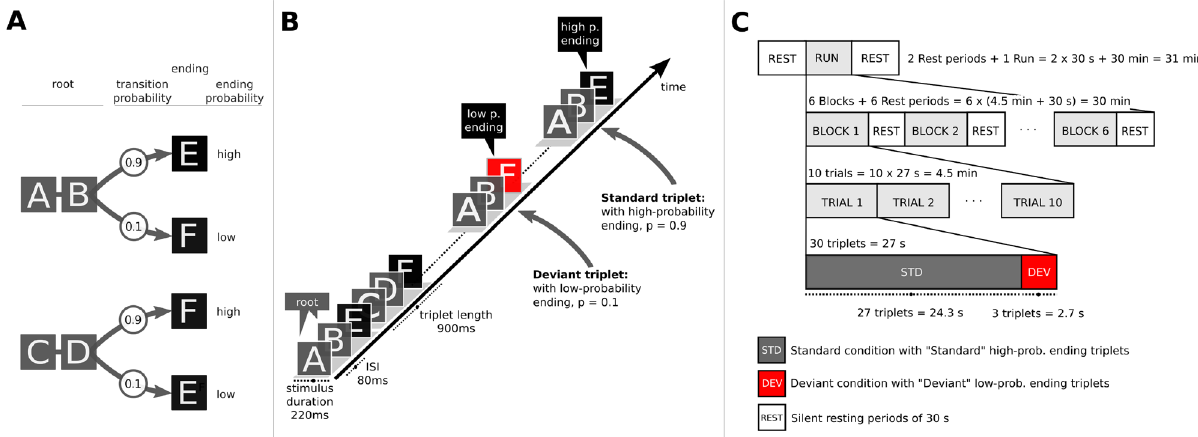
Figure 1. The experimental paradigm and auditory stream inside and outside the scanner. ( A ) The four triplets generated from the 6 sounds. The letters A to E are used to refer to the sounds. The first two items of the triplet form the root (AB and CD) and the last item the triplet ending (E or F). Statistical deviants were created by varying the transitional probability from root to ending within two levels, high (p = 0.9) and low (p = 0.1). Triplet roots (AB or CD) were occurring with a constant transitional probability (p = 0.5) from all of the triplet endings (E or F). ( B ) The auditory stream throughout the learning phase outside the scanner. The triplets